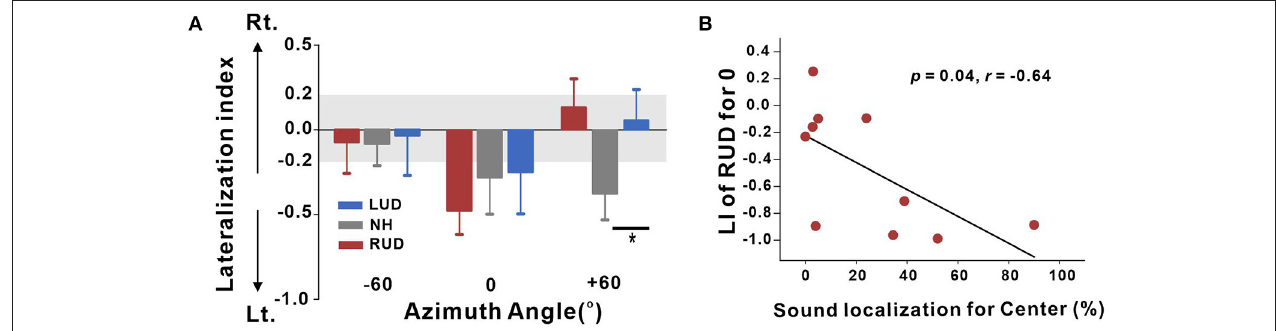
FIGURE 6 | (A) Lateralization index (LI) plots at − 60 ◦ , 0 ◦ (center), and + 60 ◦ azimuth angles for the RUD, LUD, and NH groups. The gray regions in the LI plots indicate a 0.2 criterion for laterality. (B) Significant negative correlations for the RUD group between percent correct values on sound localization task and LIs for the center. Error bars: standard error of the mean. * P < 0.05. RUD, right-sided unilaterally deaf; LUD, left-sided unilaterally deaf; NH, normal